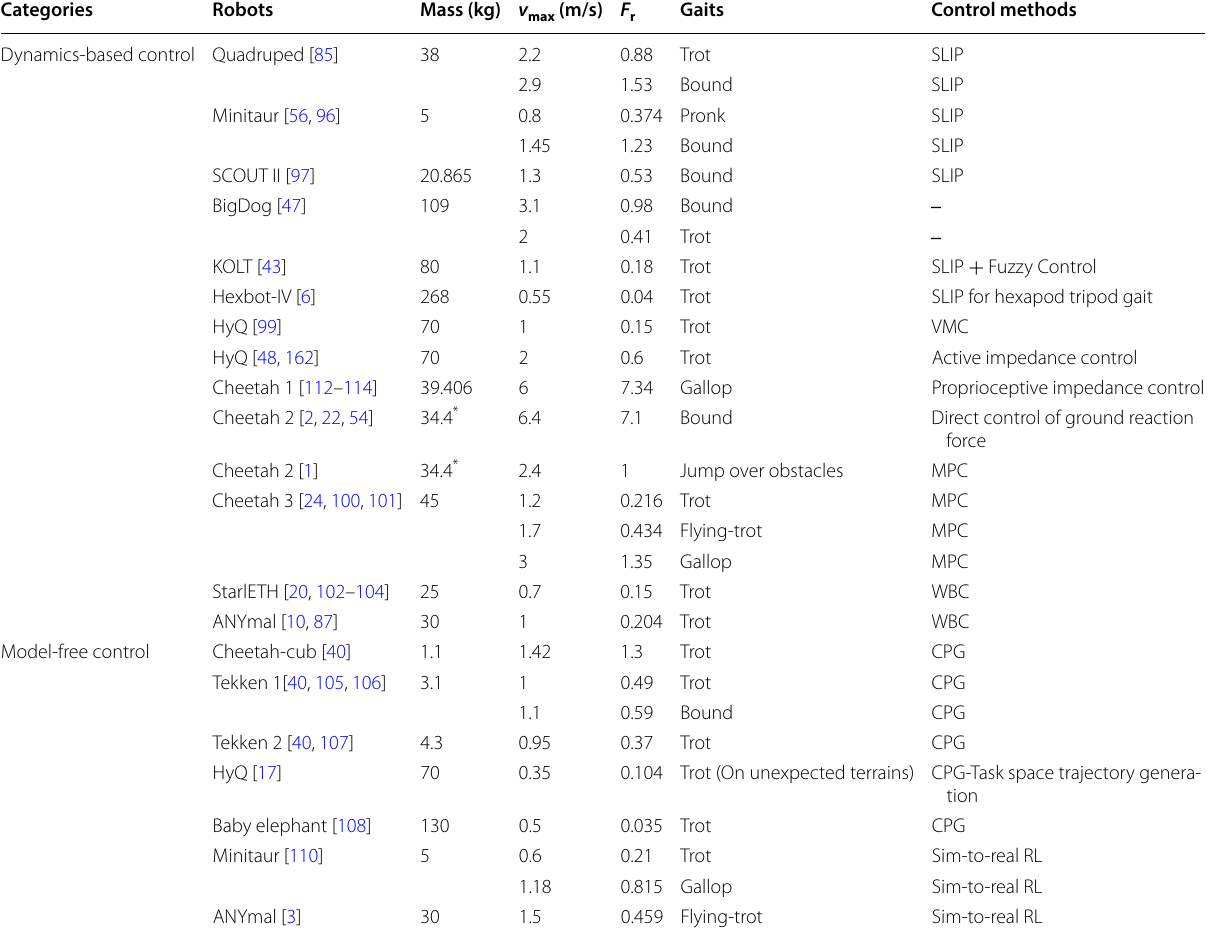
* The mass is estimated from the data in Refs. [1] and [22]